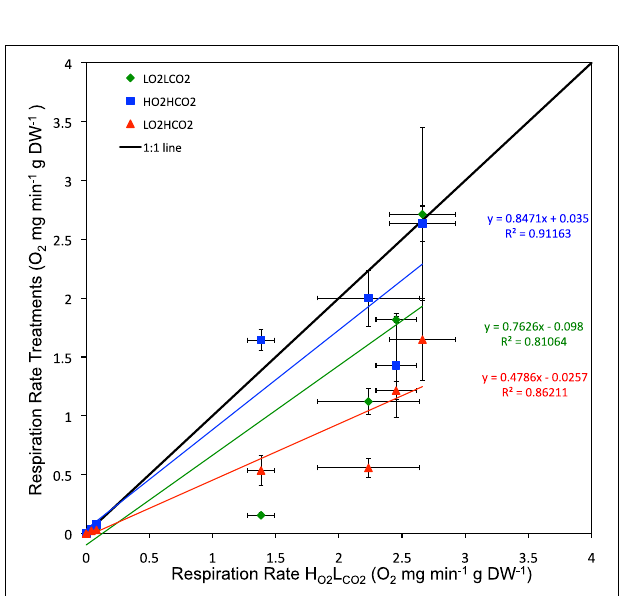
FIGURE 5 | Respiration rate vs. Respiration Index after 6 days ( ± SE; y = 0 . 63 x – 0.0385, R ² = 0.04). Solid lines show the fitted least squares regression lines for Anthozoa ( y = 0 . 637 x – 0.32; R 2 = 0 . 1 ), Mollusca ( y = 0 . 064 x – 0.022; R 2 = 0 . 85 ), Echinoderm ( y = 0 . 001 x – 0.000; R 2 = 0 . 61 ), Crustacean ( y = 1 . 083 x + 0.079; R 2 = 0 . 12 ), and Total (bold line; y = 0 . 630 x – 0.039; R 2 = 0 . 04 ); and include the ± SE of the slope, and the P -value from the F -test for each